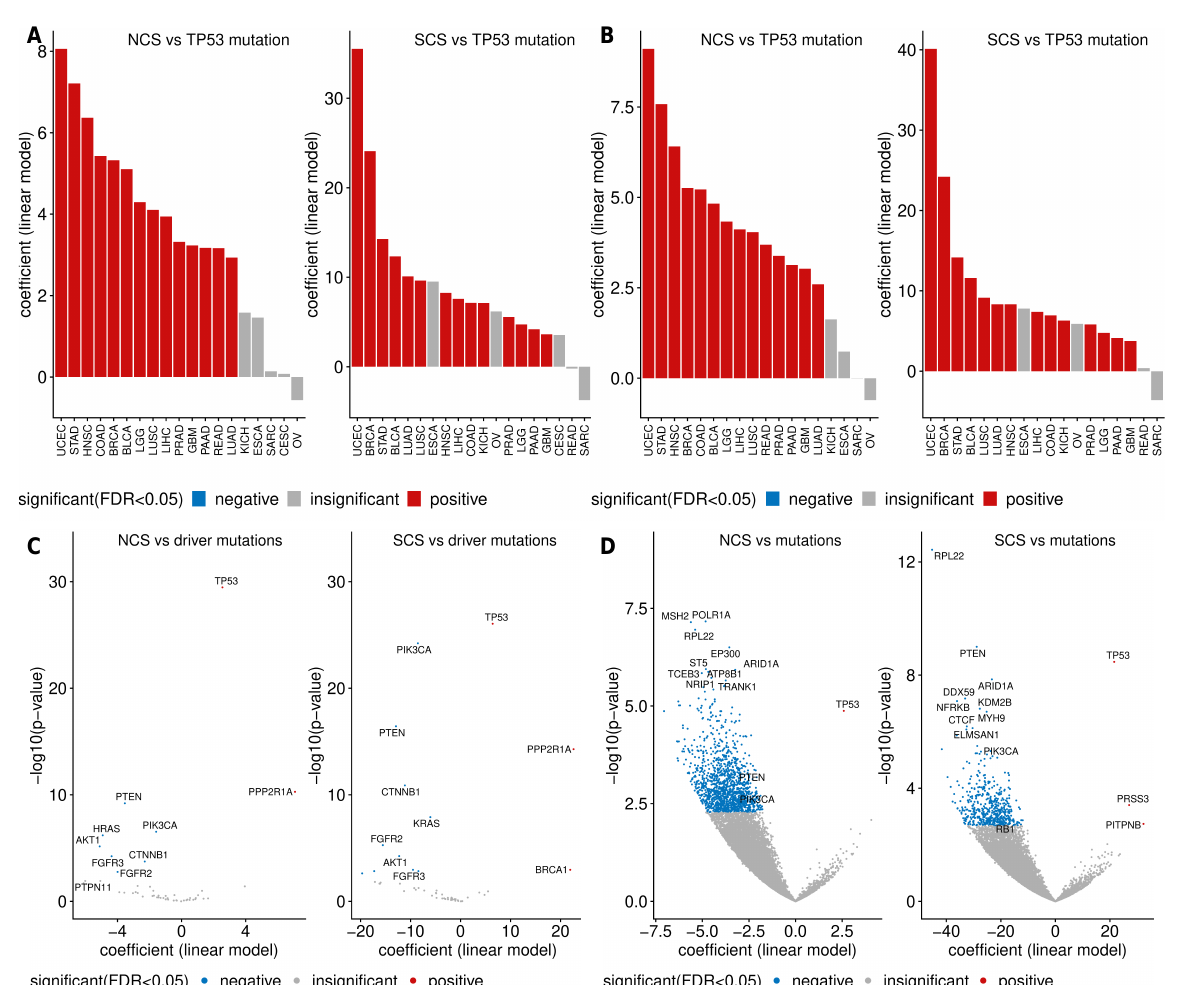
Figure A7. ( A ) TP53 mutation is positively associated with high W-CIN in multiple cancer types. The bar shows the linear regression model coefficient using NCS as dependent variable and TP53 mutation as explanatory variable. Only cancer types with both TP53 mutant and TP53 wild type in ≥ 20 samples are considered. ( B ) TP53 mutation is positively associated with SCS, the association analysis is performed as in ( A ), except excluding MIN samples. ( C ) The volcano plot shows the association between CIN and validated driver mutations, association analysis is performed using non-MIN samples only. ( D ) The volcano plot shows the correlation between CIN score and somatic mutations in CCLE cell line samples. For all associations in ( A – D ), red, grey and blue encode positive, insignificant and negative associations. FAD-adjusted p ≤ 0.05 is considered as significant. Gene names of known important oncogenes and CIN driver genes are annotated in the volcano plot, if significantly associated with